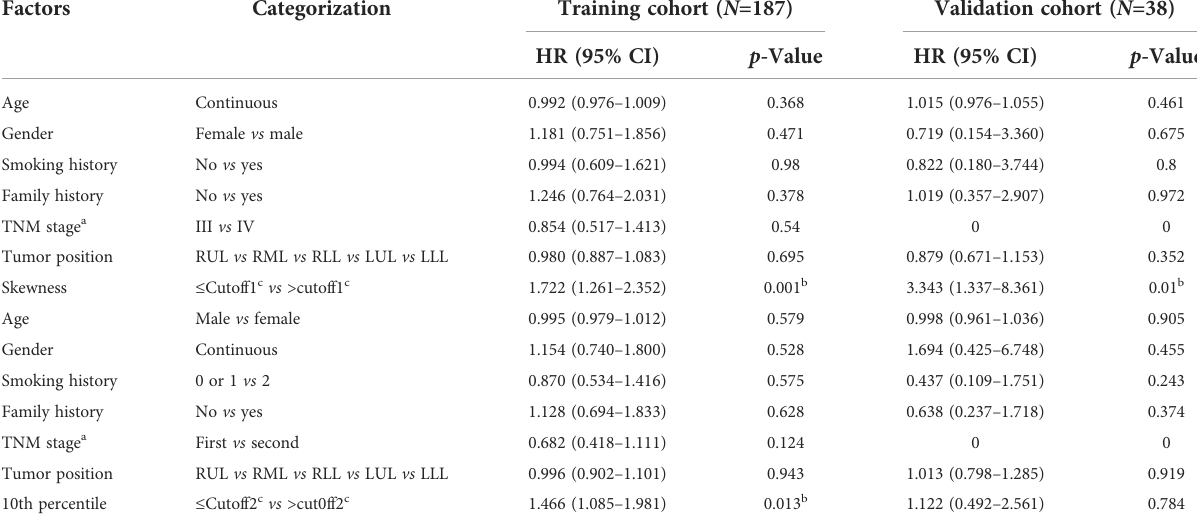
TABLE 3 Multivariate analysis of the categorization of two features and